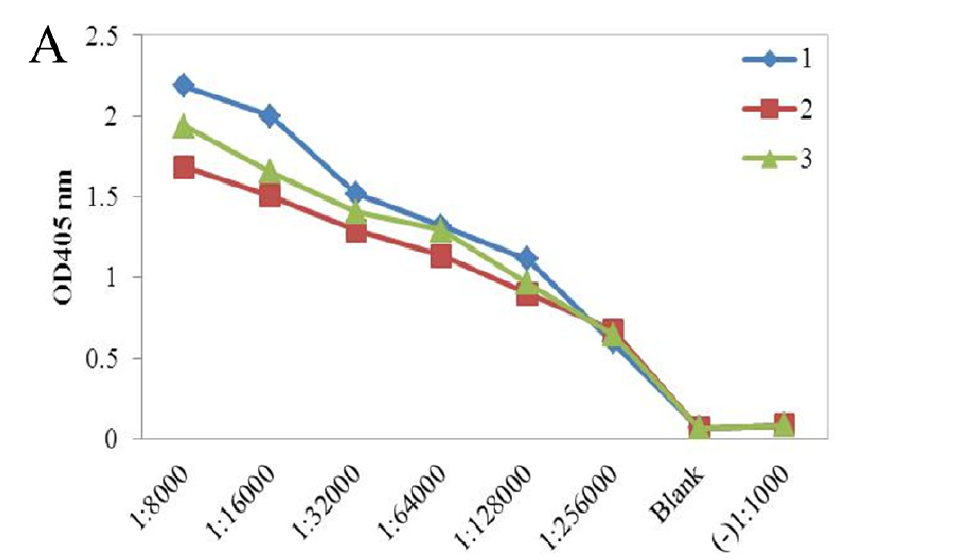
Figure 1. (A) Titers of the three SRBSDV S10 polyclonal antibodies. 1-3 represent antibodies 1, 2, 3 respectively. (B) Specificity analysis of the three SRBSDV S10 polyclonal antibodies 1, 2, 3 (from left to